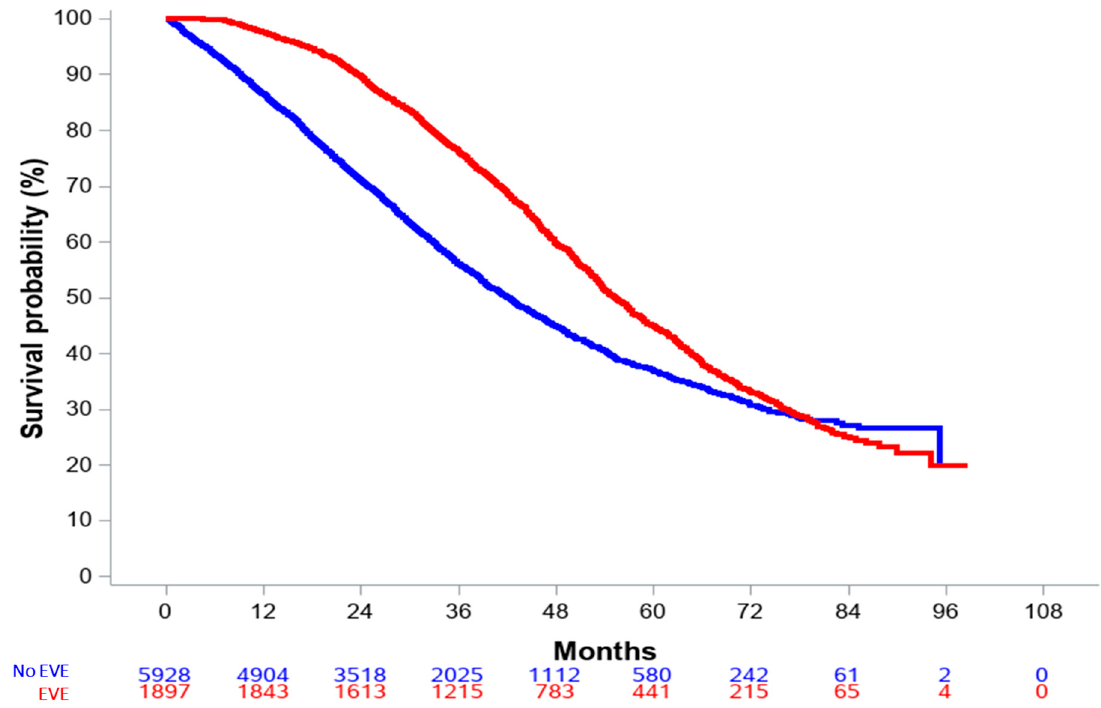
Figure 2. Overall survival in the entire population, according to everolimus exposure.